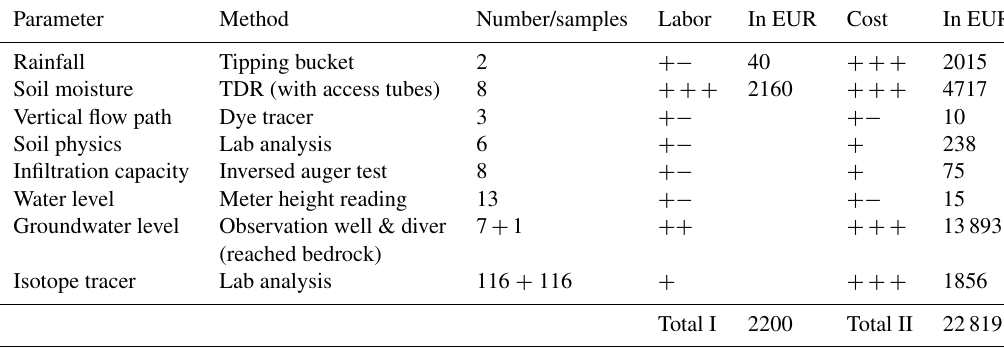
(reached bedrock)